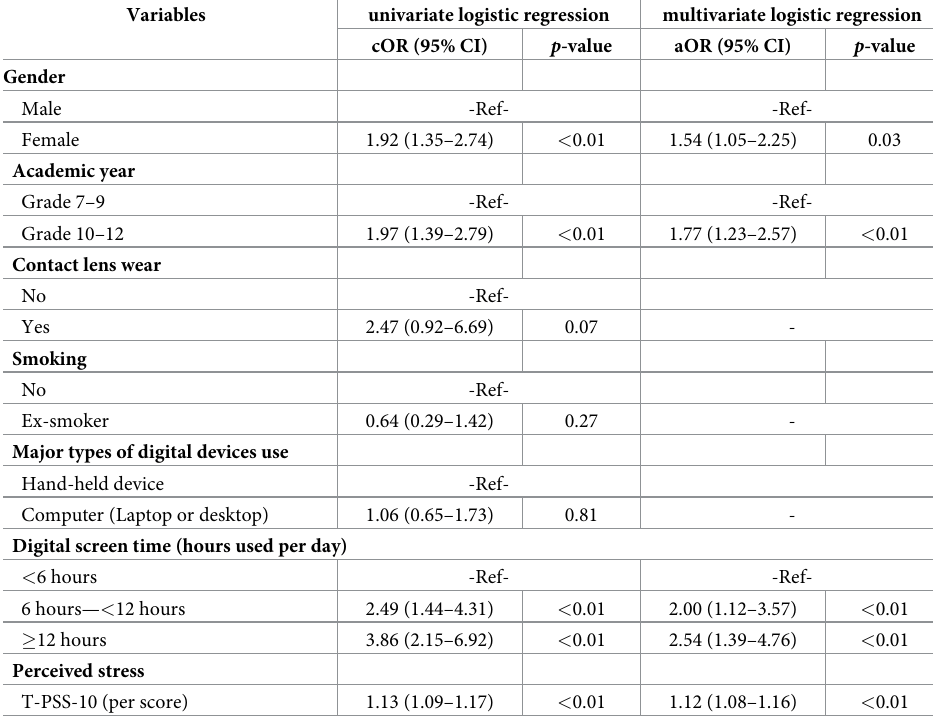
Table 3. Univariate and multivariate logistic regression among study respondents (N =